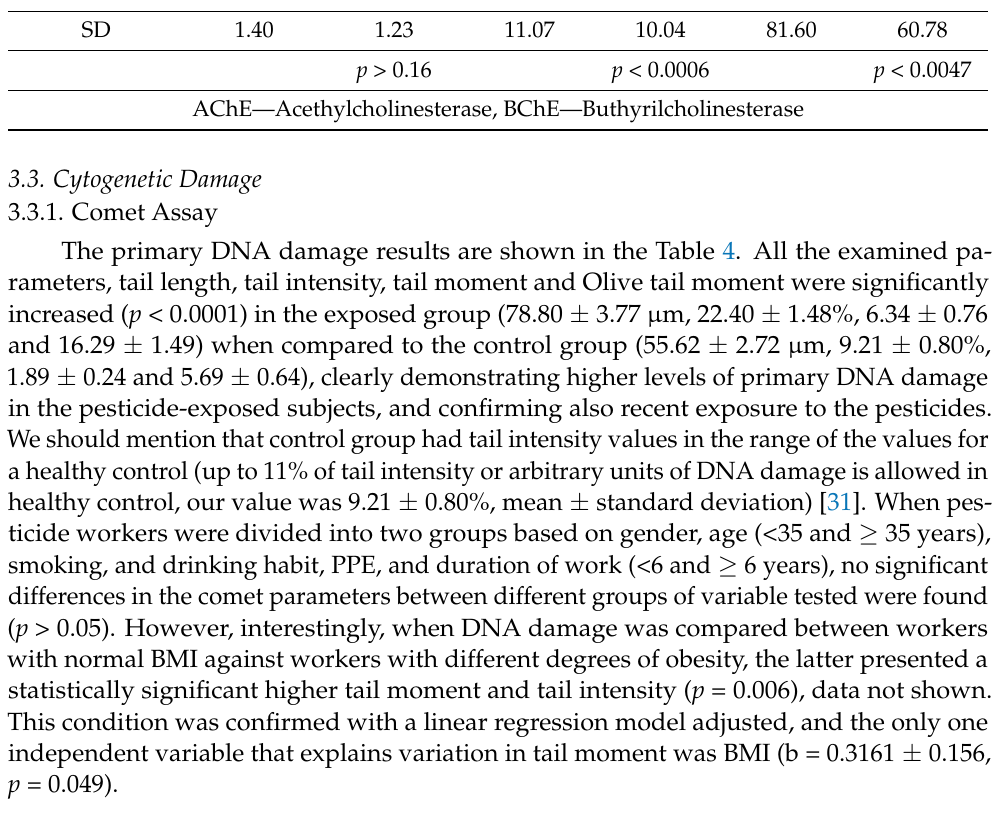
Table 4. Human biomonitoring of agricultural workers from Zamora-Jacona in Michoacan Mexico with different cytogenetic